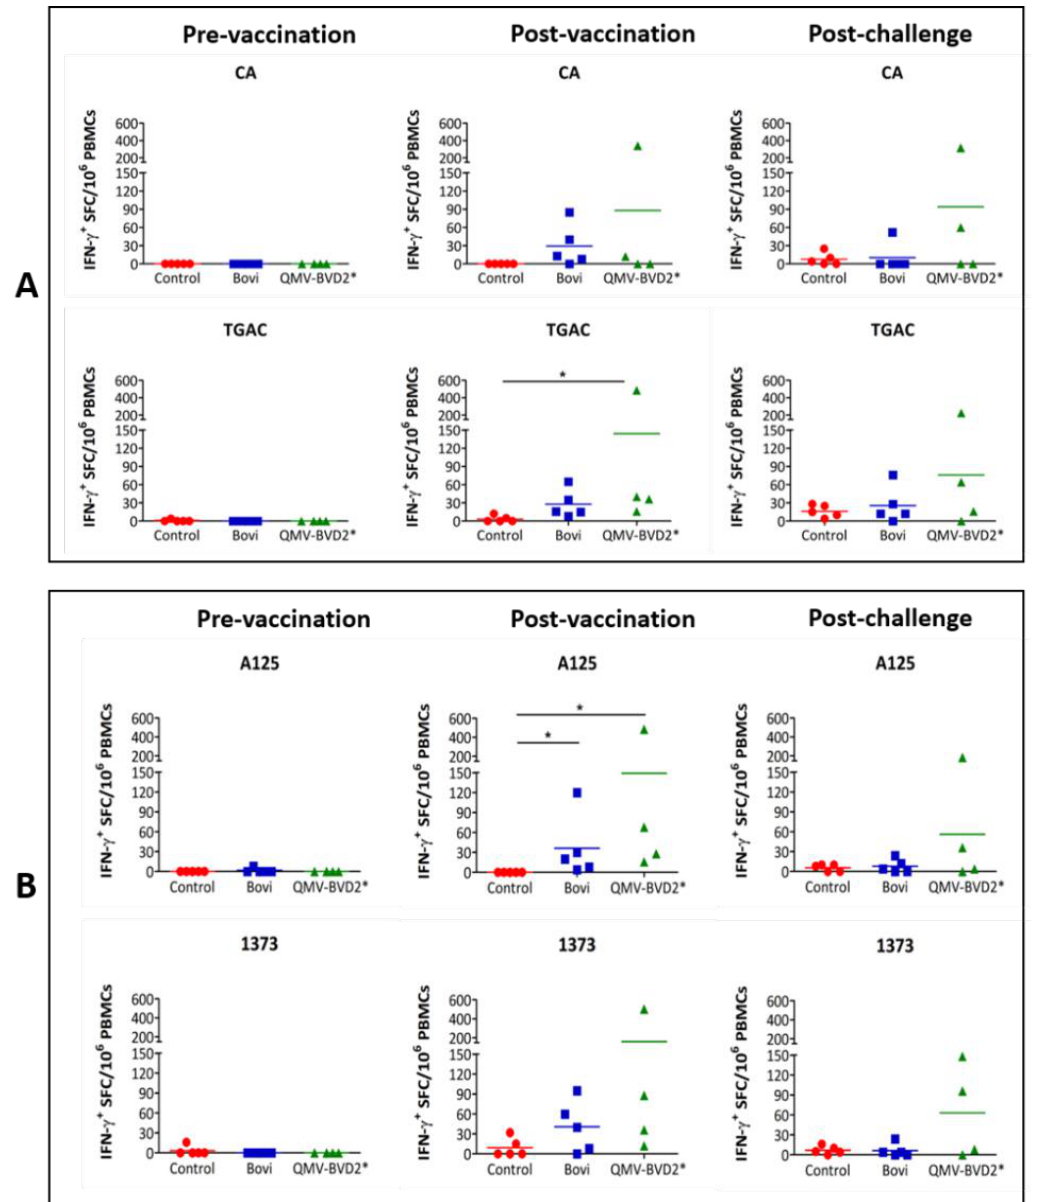
Figure 6. Pre–vaccination, Post–vaccination, and post–challenge BVDV–1 ( A ) and BVD2 ( B ) strain–specific IFN– γ cellular responses. IFN– γ secreting PBMC responses against BVDV–1 (CA and TAGC) and BVDV–2 (A125 and 1373) strains were determined by IFN– γ ELISPOT assays. The response is presented as IFN– γ + SFC/10 6 PBMCs. Medium alone served as the negative control, and the data shown are normalized by deducting media background counts. The group mean is represented by a bar. Asterisks denote statistically significant differences between the groups (* p < 0.05).